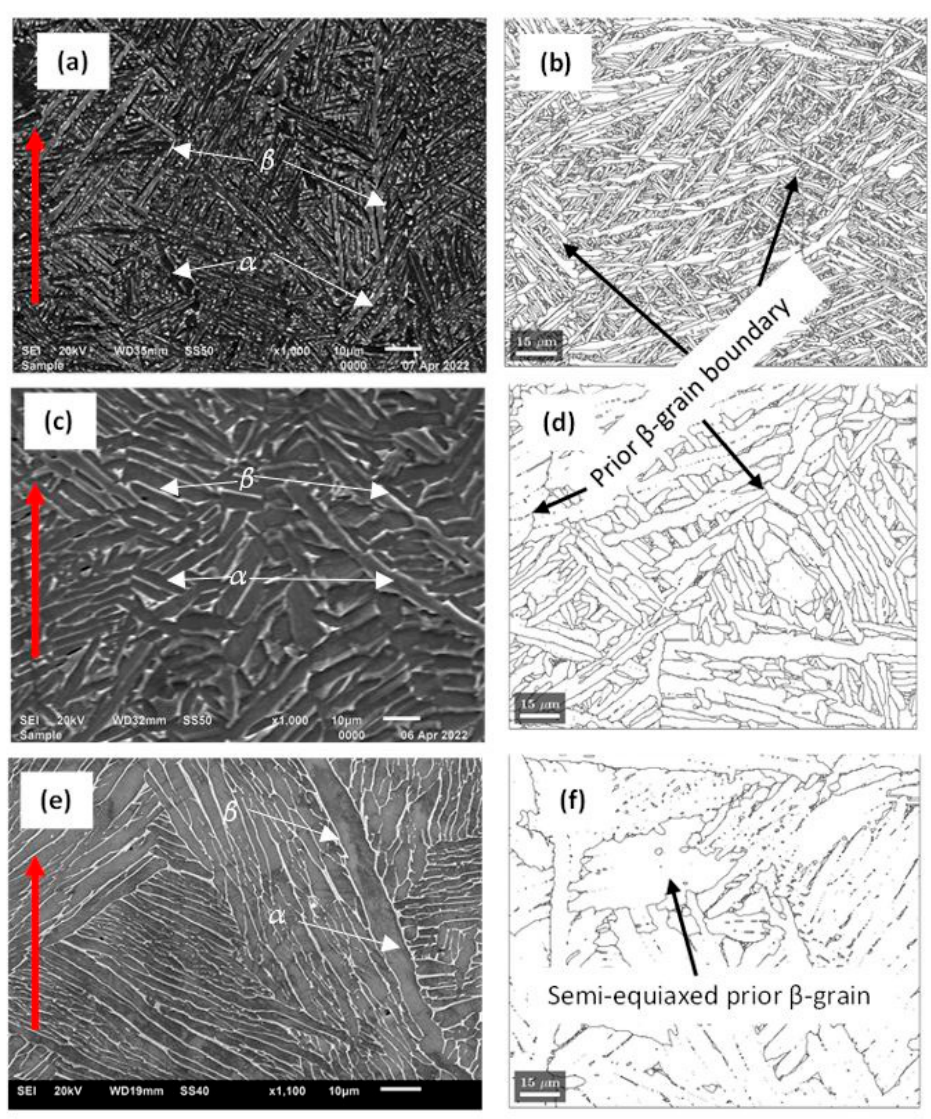
Figure 4. The secondary electron images (SEI) of samples ( a ) C, ( c ) D and ( e ) E and α -grain boundary distribution in samples ( b ) C, ( d ) D and ( f ) E. The red arrows indicate the build orientation.